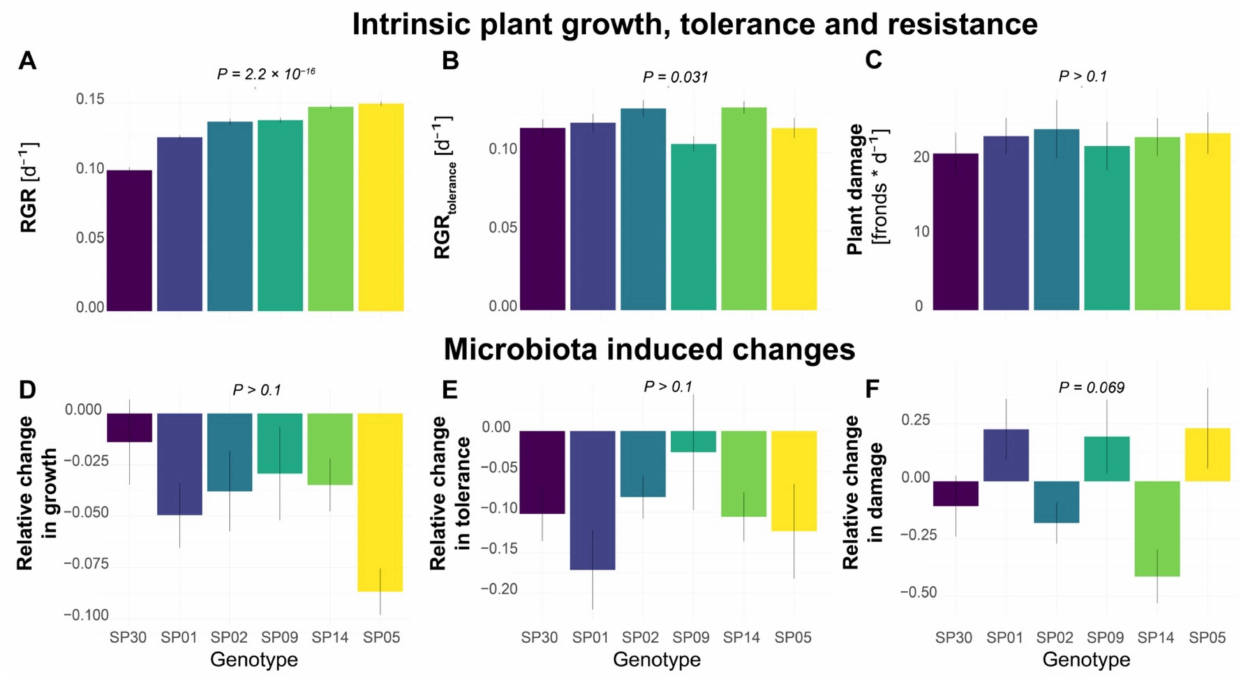
Figure 1. Intra-specific variations of microbiota effects on plant growth, tolerance, and resistance to the snail herbivory in S. polyrhiza. ( A ) Relative growth rate (RGR) based on the number of fronds grown within a week. ( B ) Tolerance as RGR within 5 days after snail herbivory (RGR tolerance ). ( C ) Plant damage, which was calculated as the number of fronds consumed or damaged by one L. stagnalis within 24 h and represents the level of plant resistance to herbivory, with high damage levels indicating low resistance. ( D – F ) The effects of plant microbiota on growth rate, tolerance, and resistance to snail herbivory, estimated as the percentage of the growth/tolerance/damage rate that was altered by the pre-treatment with a microbe inoculum. Positive and negative values refer to increased or decreased growth/tolerance/resistance levels. Columns represent mean values and error bars show the standard error. Each column represents a genotype with N > 16 for ( A , D ) and N > 11 for ( B , C , E , F ). p -values refer to genotype effects.